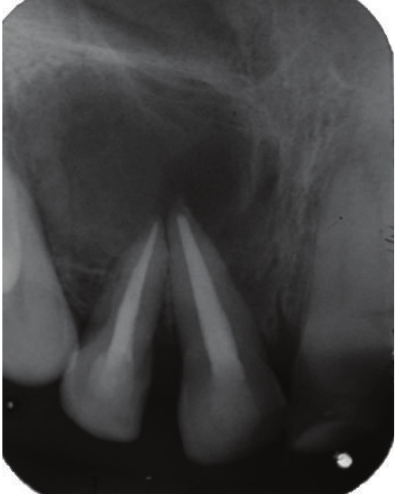
Figure 33: Postobturation IOPA radiograph.